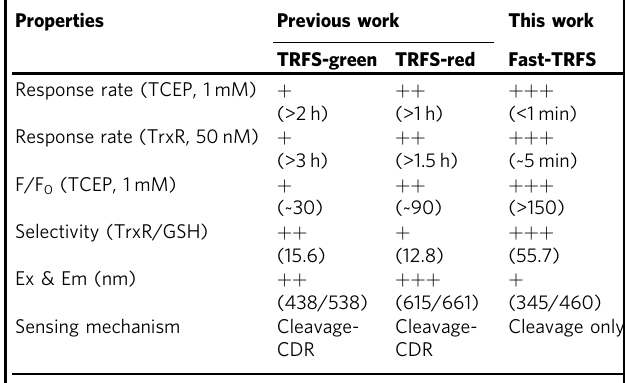
Table 1 Comparisons of TRFS-green, TRFS-red and